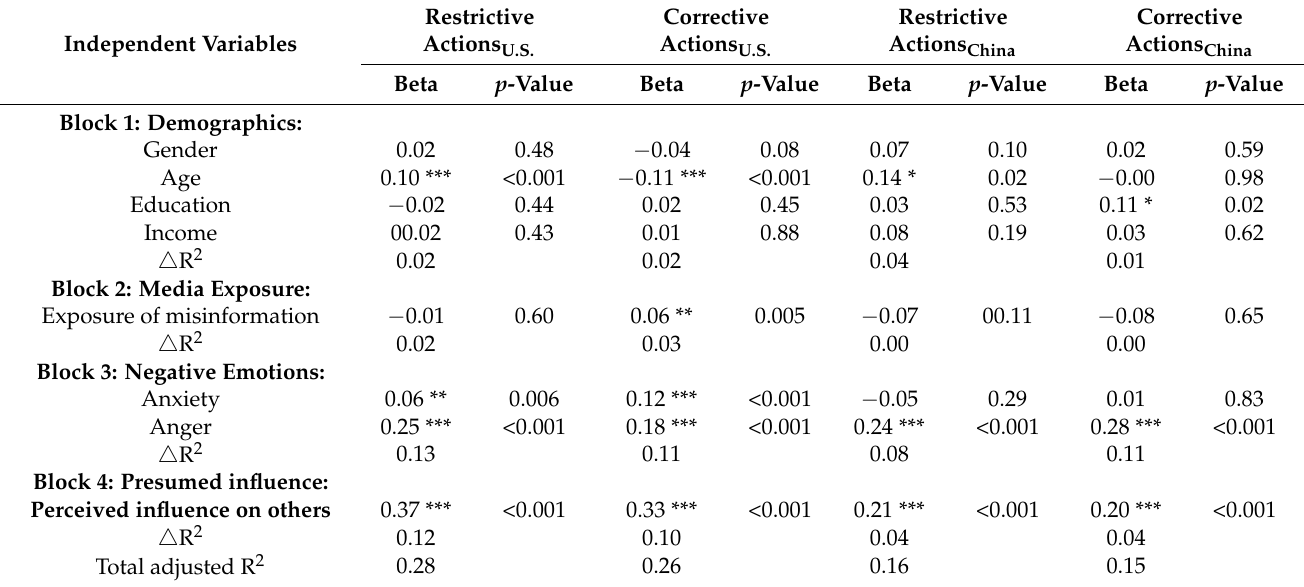
Table 2. Hierarchical Regression Analysis Predicting Support for Restrictive and Corrective Actions in both U.S. and China.